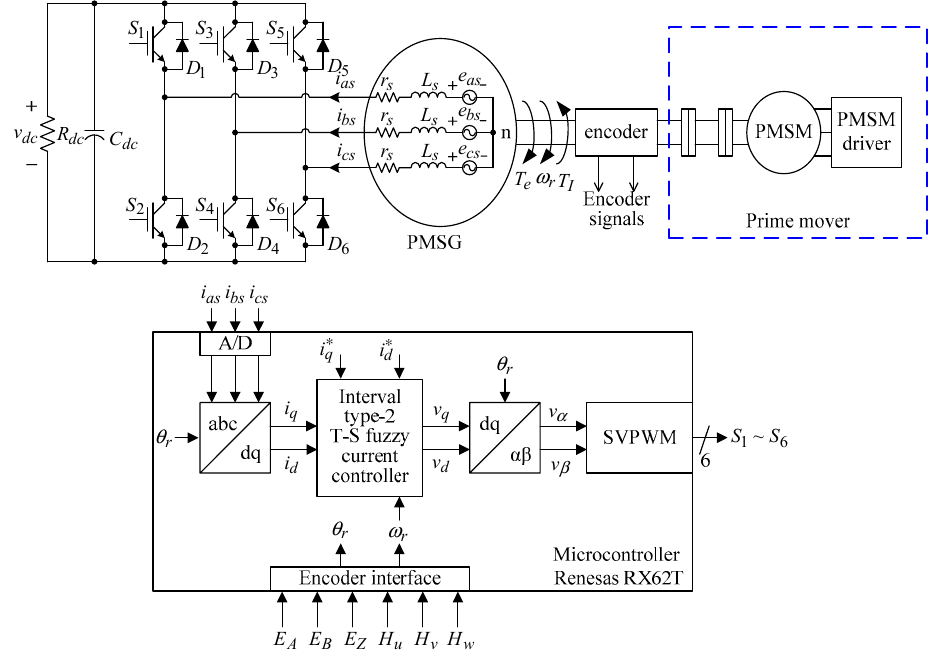
Figure 1. System configuration of the PMSG based on theIT2 T-S fuzzy control systems.